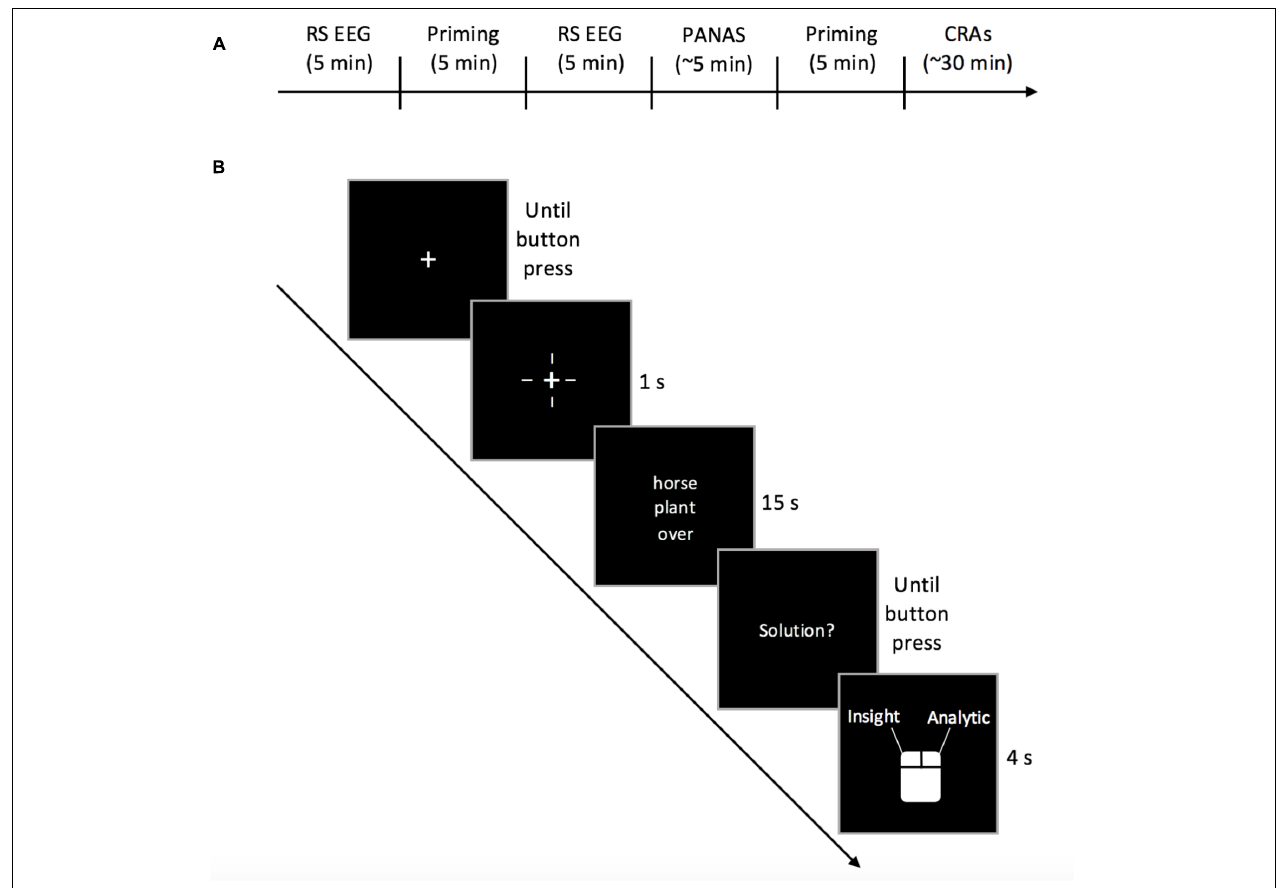
FIGURE 1 | (A) Experimental procedure timeline and (B) CRA